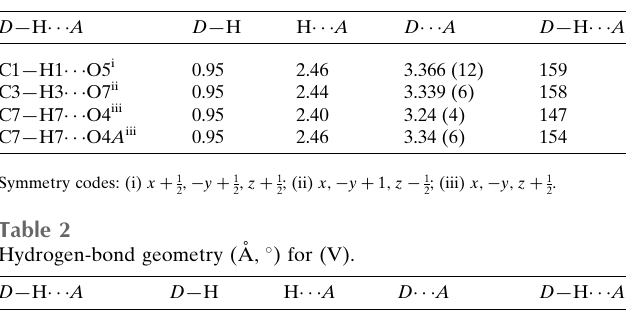
Table 1 Hydrogen-bond geometry (A˚ , (cid:2) ) for (I).